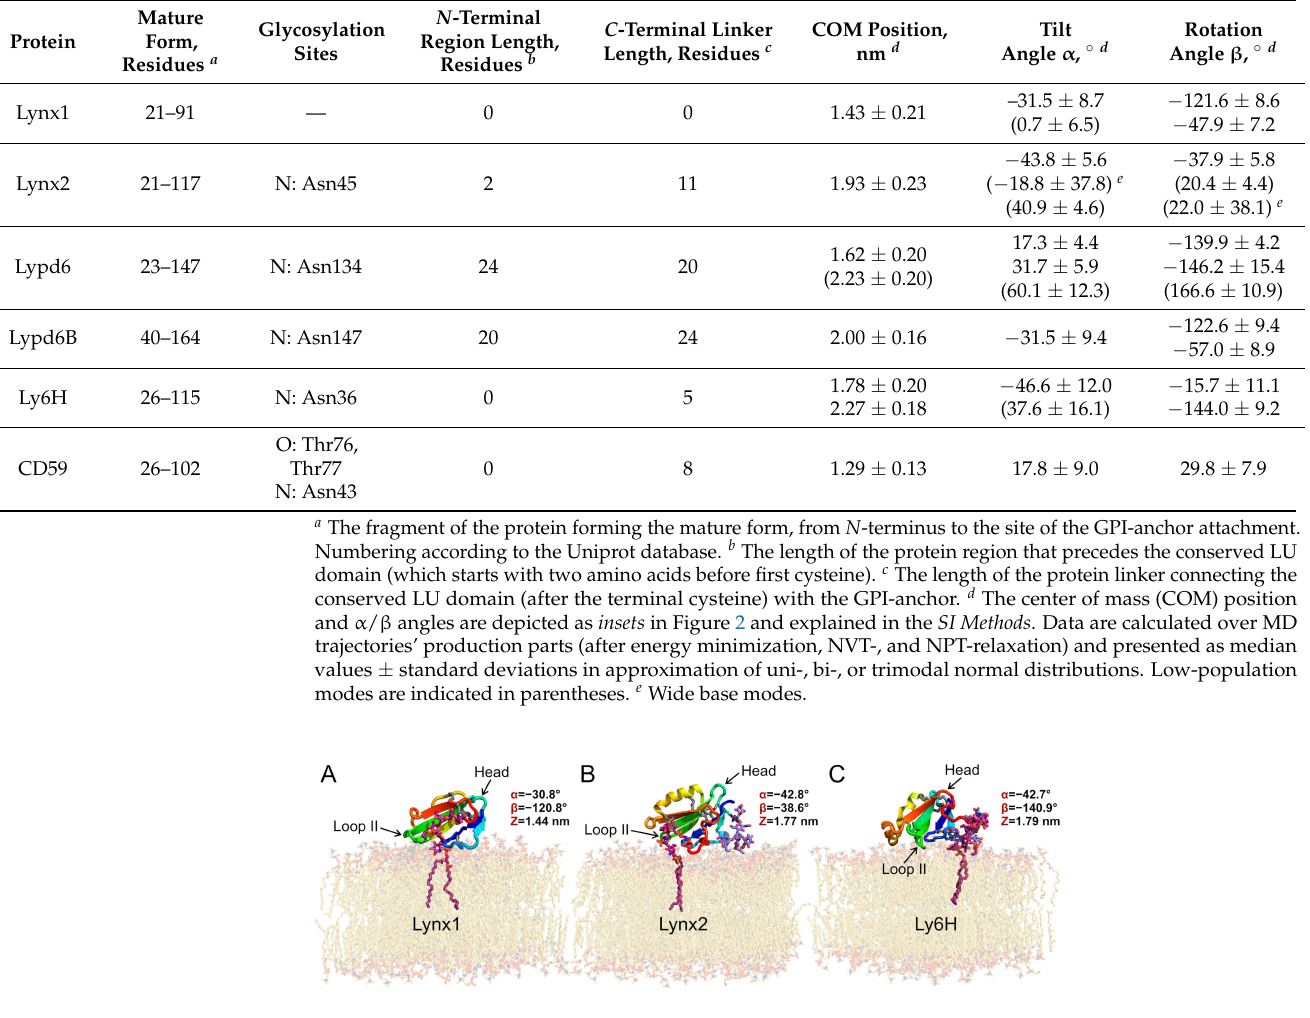
Table 1. Positional and orientational preferences of GPI-anchored Ly6 proteins in the membrane.